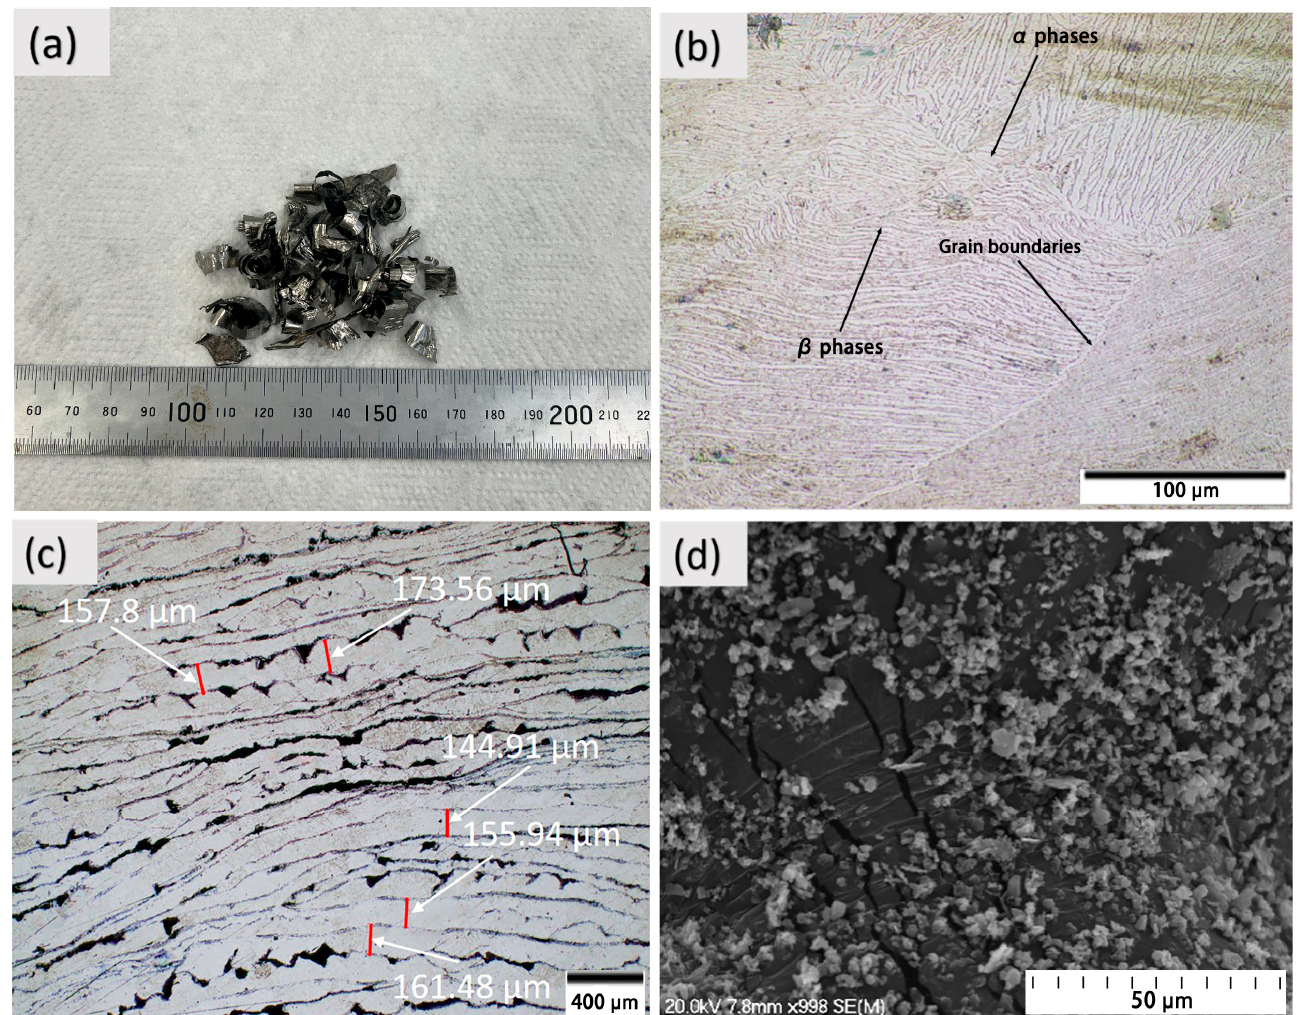
Figure 1. ( a ) As-received Ti-6Al-4V chips; ( b ) initial microstructures of as-received chips; ( c ) thickness of Ti-6Al-4V chips before hot pressing; and ( d ) amorphous boron powder. To remove the residual coolant and dust, the chips were rinsed in hot water with a dishwashing liquid, followed by ultrasonic cleaning in 99.5% ethanol for 1 h. Then, the Ti-6Al-4V chips were crushed into small chips. The well-cleaned chips and x vol.% (x = 1, 3, 5, and 7) of boron powder were mixed in a V-type mixer (Jiangyin Rongde Machinery, Jiangyin, China) at a speed of 60 rpm, and the mixing time was 120 min. After that, the well mixed chip mixture was warmly compacted into green compacts (56 mm in diameter and 28 mm in height) at 250 ◦ C prior to hot processing. The compact was subsequently heated up to 1250 ◦ C using an induction furnace (Inductotherm Ltd., Seaford, Australia) and then hot pressed into a cylinder-shape billet (58 mm in diameter and 18 mm in height) using a 100 ton hydraulic press (Inductotherm Ltd., Seaford, Australia). The applied pressure was 400 MPa, and the hot-pressing time was 90 s. The whole hot-pressing process is under the protection of Ar gas (O 2 < 200 ppm). Thus, the change in oxygen content of the composite material after hot pressing is negligible. For details on the change in oxygen content, refer to reference [14]. Figures 2 and 3 show a schematic illustration of the hot-pressing process and the appearance of green compacts and hot-pressed billets. In-depth experimental details regarding the hot-pressing procedures can be found in the references [29,30].